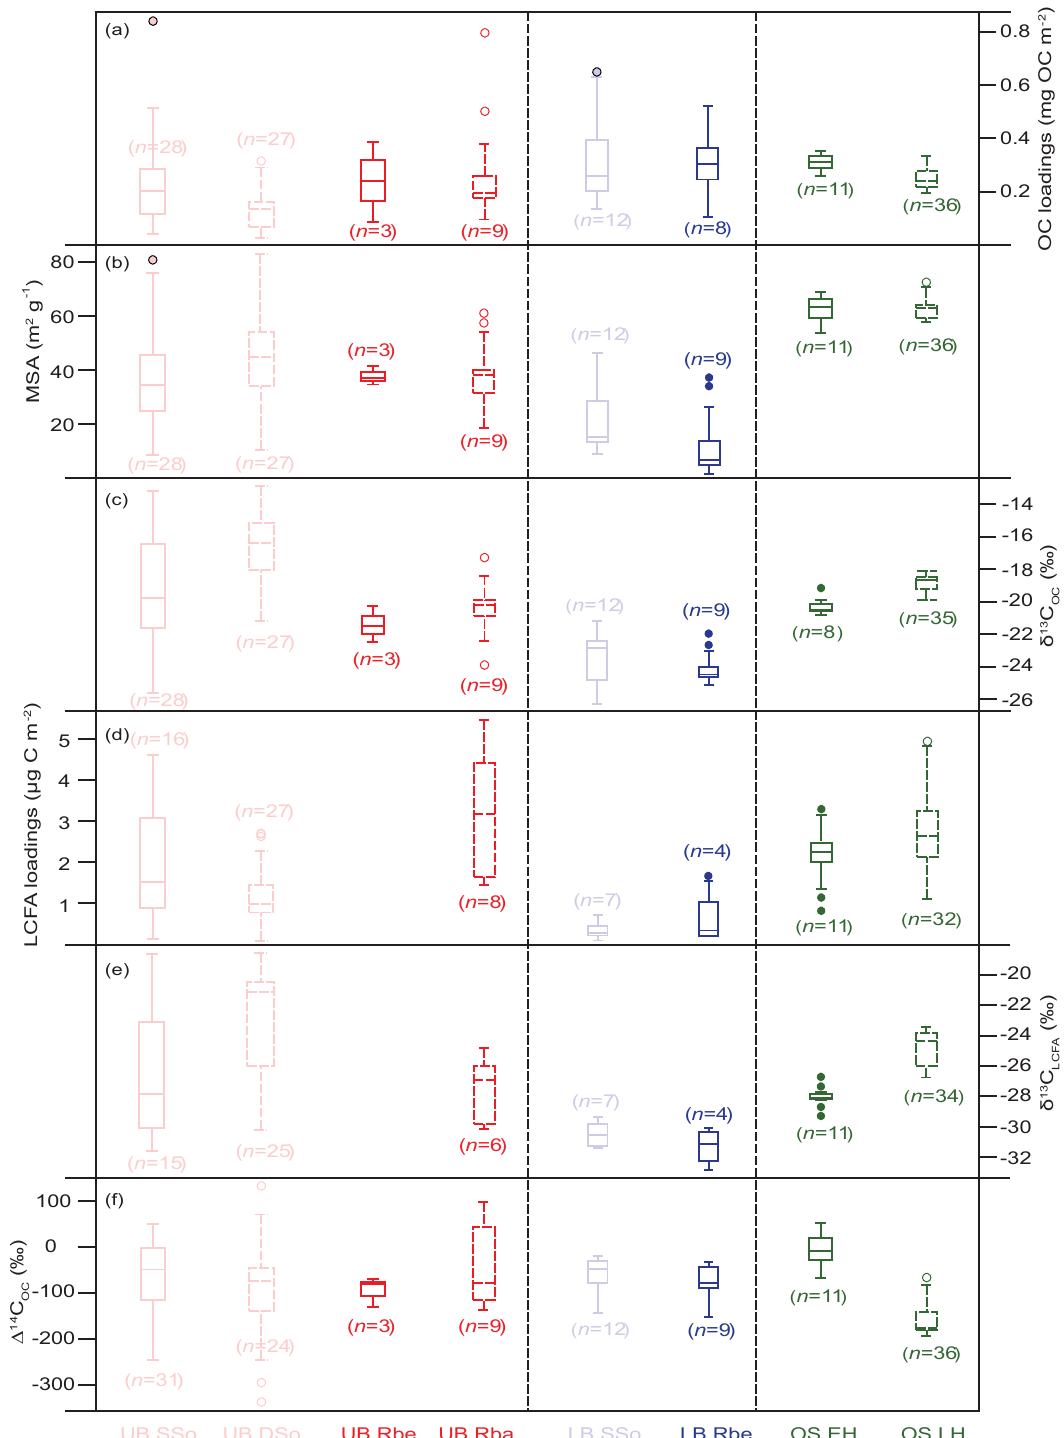
Figure 8. Box-and-whisker summary of the geochemical and sedimentological data for the Godavari River basin and offshore sediments. (a) Organic carbon loadings, (b) mineral surface area (MSA), (c) bulk stable carbon isotope ratio, (d) long-chain fatty acid loadings, (e) mean weighted stable carbon isotope ratio of long-chain (C 26 − 32 ) fatty acid, and (f) bulk radiocarbon signature. The box represents the first (Q1) and third quartiles (Q3), and the line in the box indicates the median value. The whiskers extend to 1.5 · (Q3–Q1) values, and outliers are shown as points. SSo = surface soil; DSo = deep soil; Rbe = riverbed; Rba = riverbank; EH = early Holocene; LH = late